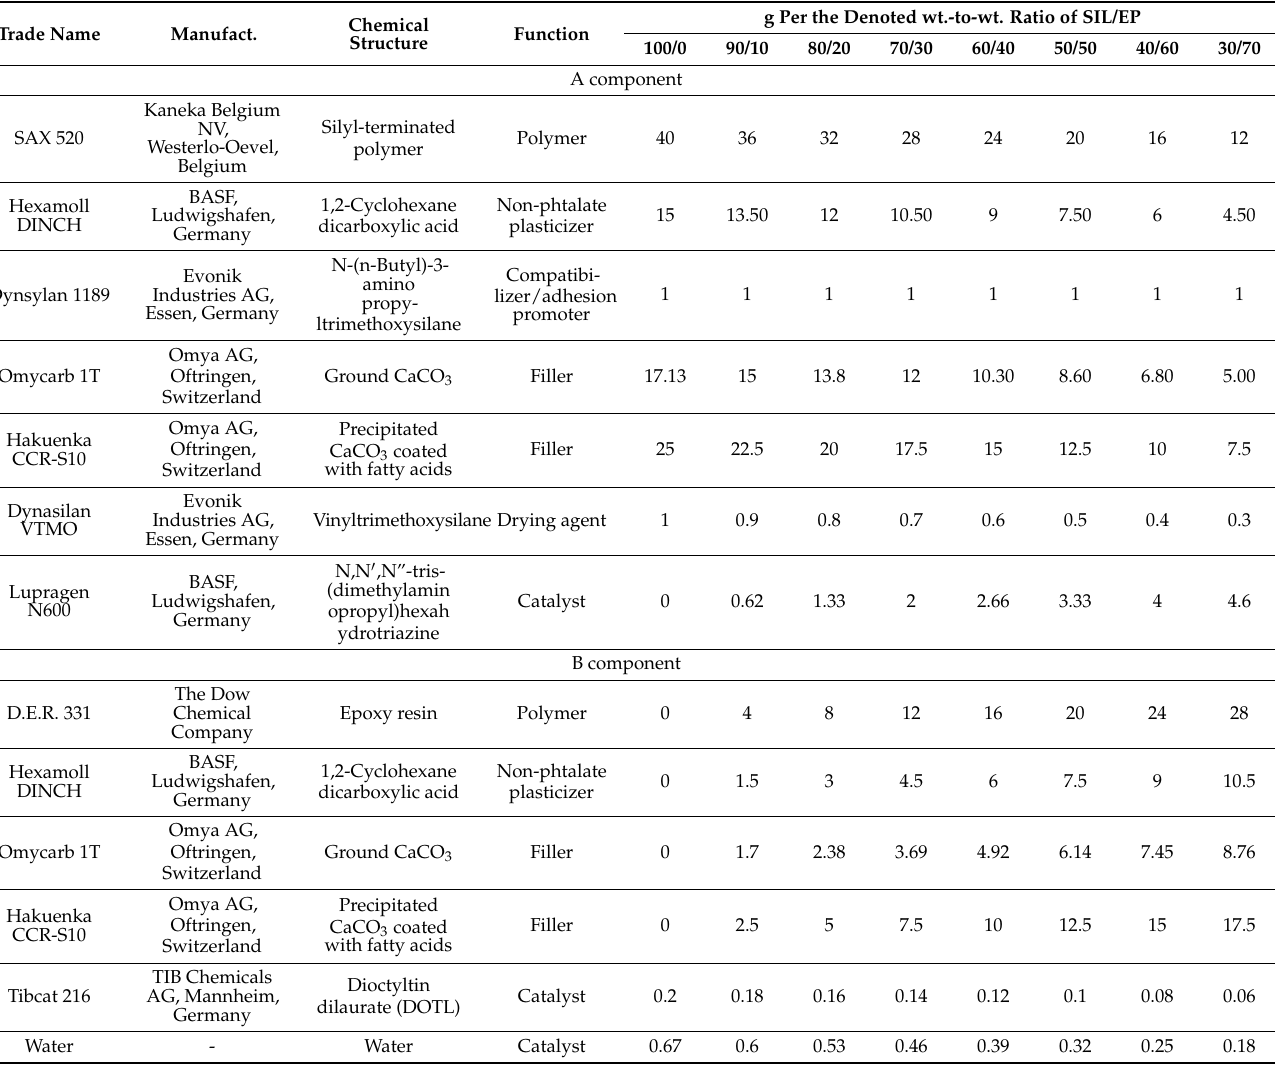
Table 3. Characterization of two-component SIL/EP formulations (completed